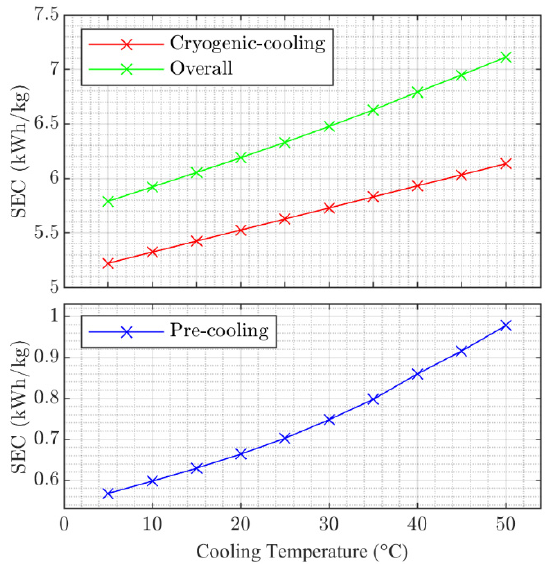
Figure 8. Variation in SEC with cooling temperature for the pre-cooling, cryogenic-cooling and overall cooling processes.